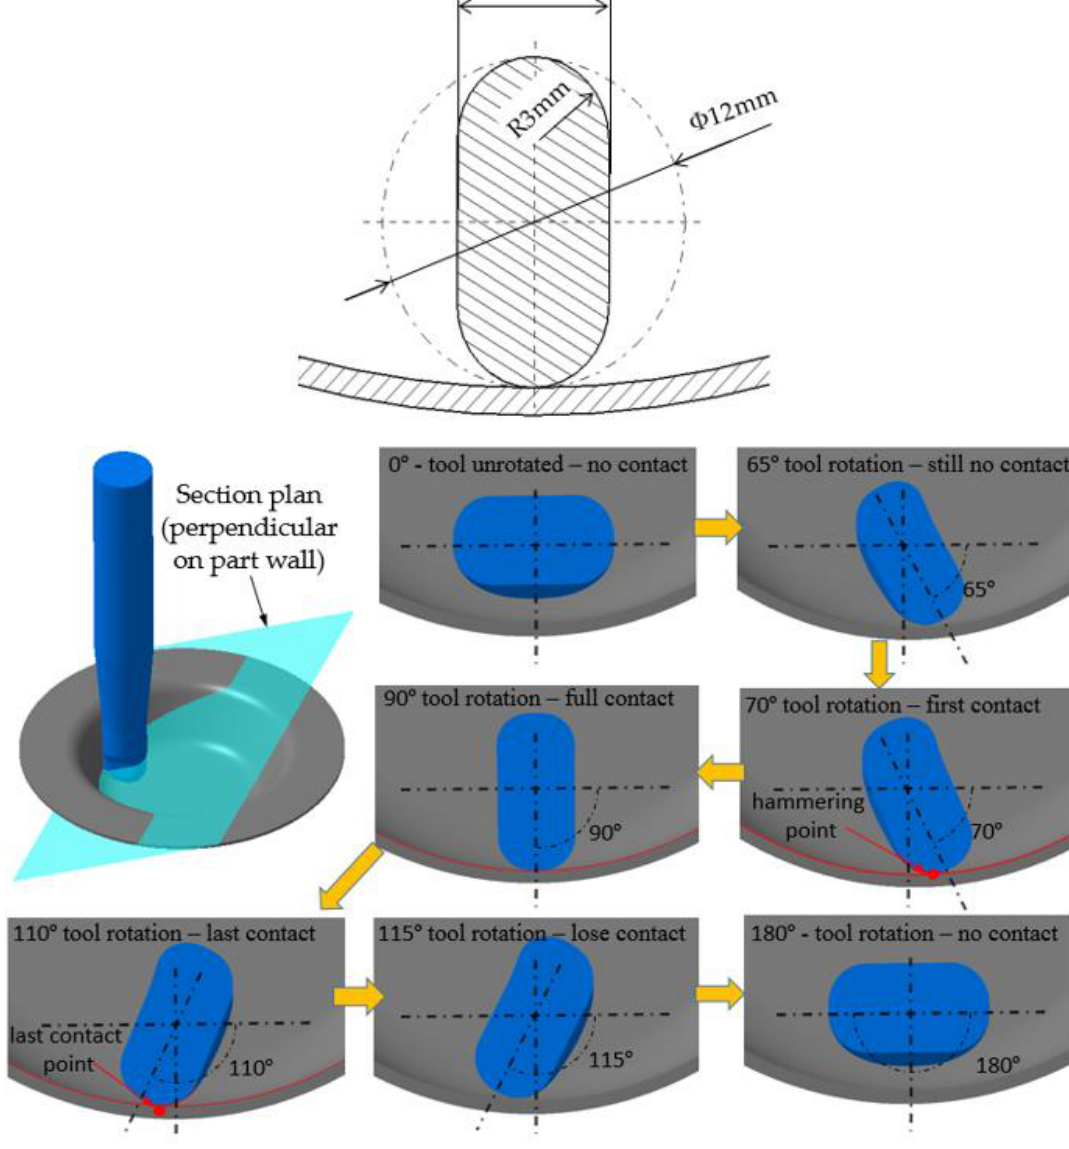
Figure 7. The 0−180° kinematic cycle presented for the circumferential hammering tool (CHT). Figure 7. The 0–180 ◦ kinematic cycle presented for the circumferential hammering tool